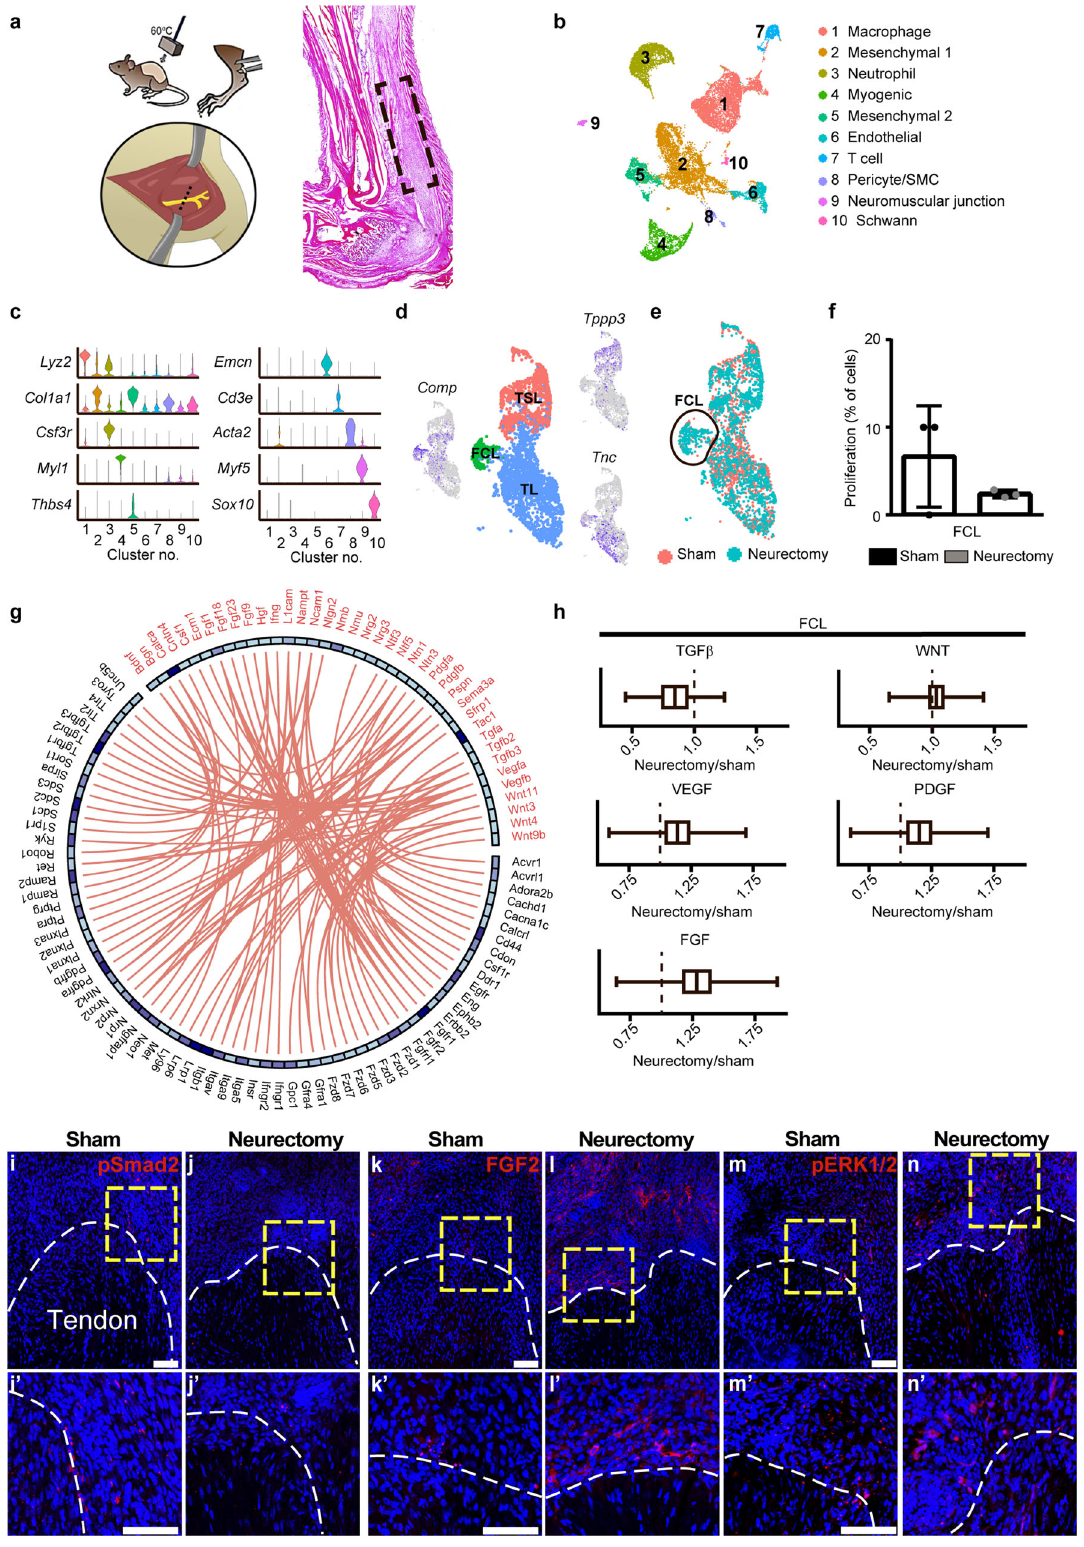
(encoding SP) nor the receptor Tacr1 in the local HO site. Of note, axons are not sampled using scRNA-seq, and the extent to which peptidergic axon-derived SP modulates HO in the present model needs to be further addressed. Other investigators have observed that Hedgehog signaling plays a well-established role in HO development 60 . In addition, Hedgehog ligands released from